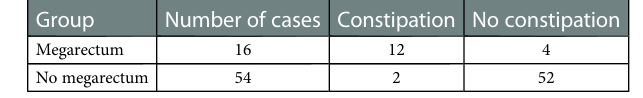
Table 2 Comparison of postoperative defecation function between the two groups. Group